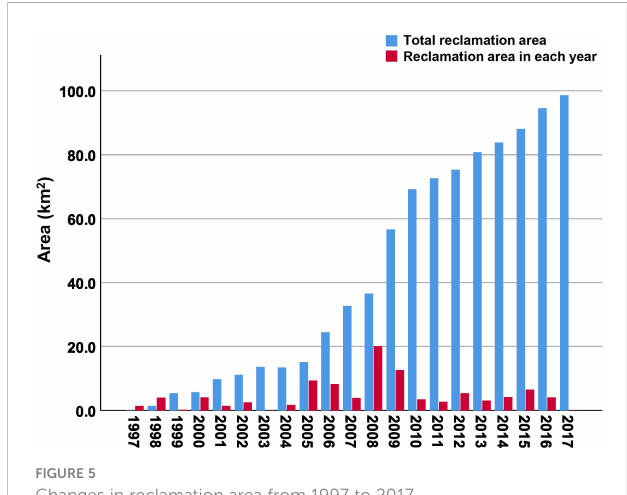
FIGURE 5 Changes in reclamation area from 1997 to 2017.